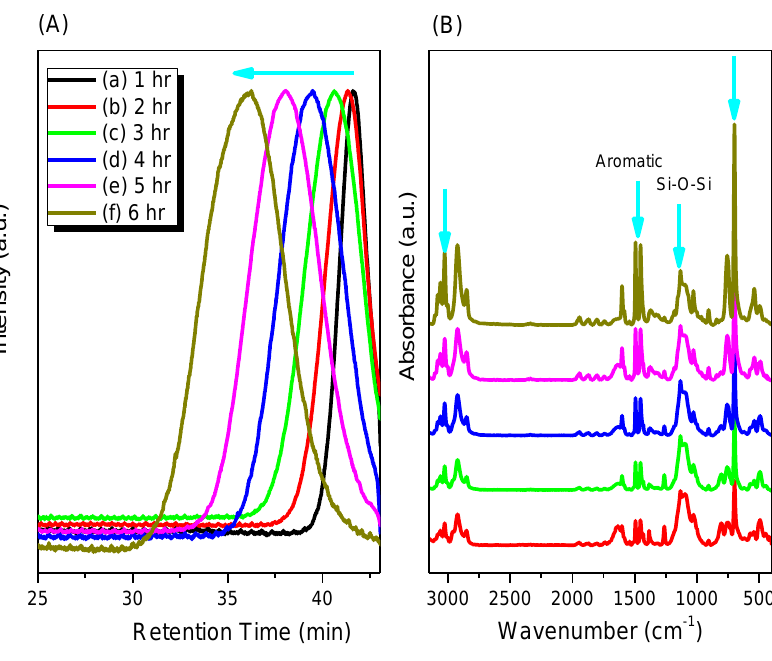
Figure 3. ( A ) SEC and ( B ) FTIR spectra of PS-DDSQ-PS homopolymers prepared with ATRP reaction times of ( a ) 1, ( b ) 2, ( c ) 3, ( d ) 4, ( e ) 5, and ( f ) 6 h.